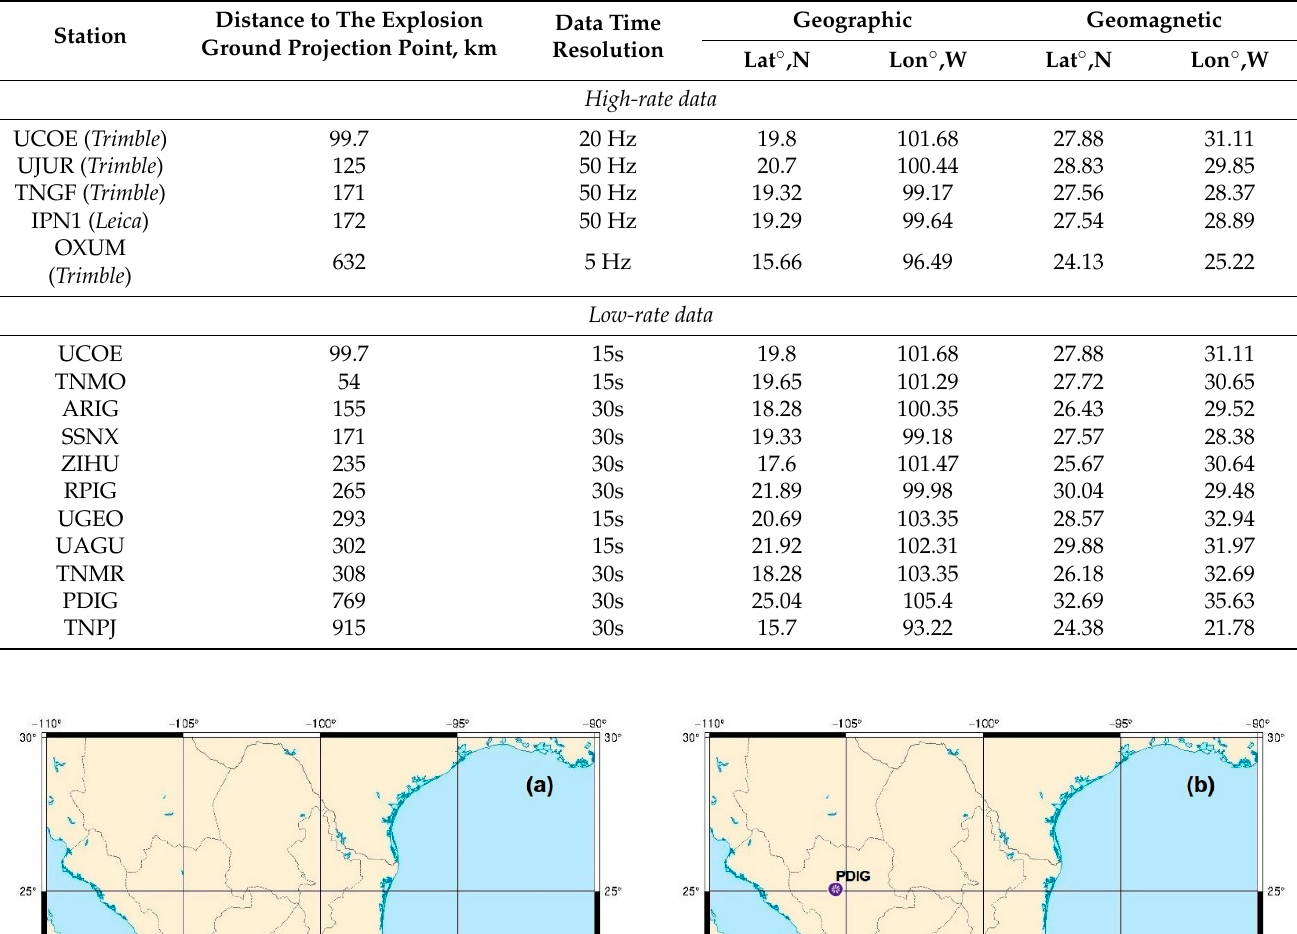
Table 2. GNSS receivers whose data were involved in the analysis.